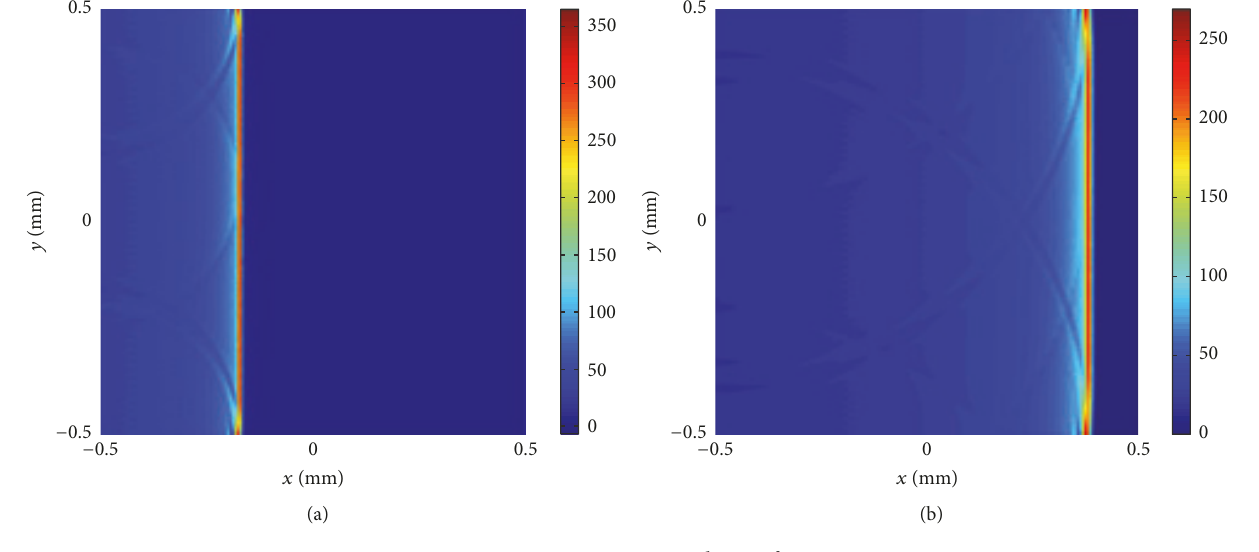
Figure 7: Pressure at 𝑡 = 1.2 𝜇 s and 3.2 𝜇 s for 𝜏 ℎ = 0 .